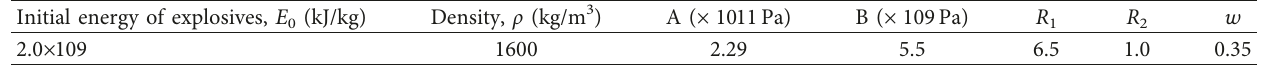
Table 1: Parameters used for the Jones–Wilkins–Lee law describing the explosive